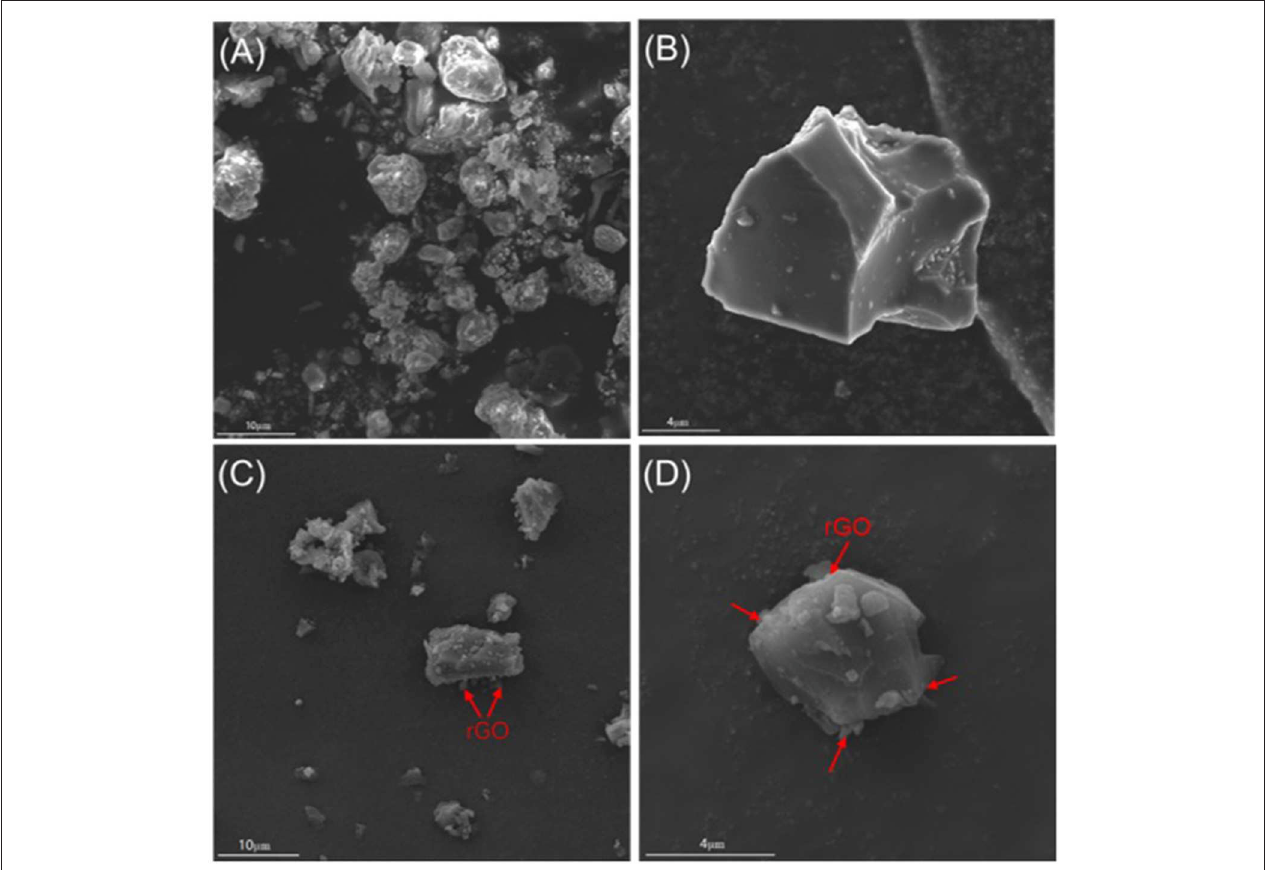
FIGURE 2 | SEM images of SHC (A,B) and SHC@rGO (C,D) composites.